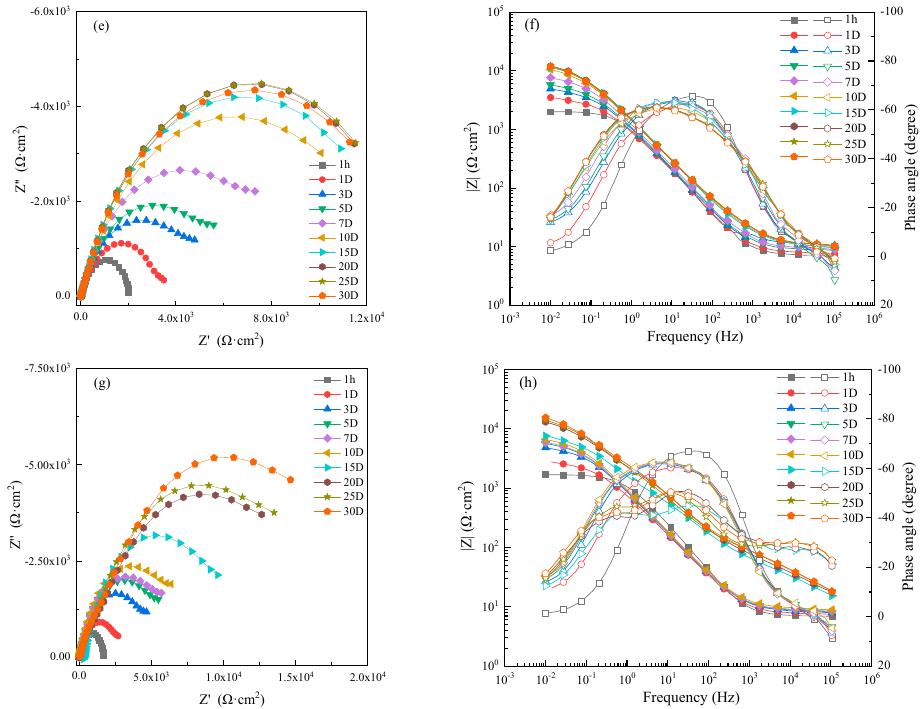
Figure 7. Electrochemical impedance spectra of HAZ in seawater: ( a , c , e , g ) Nyquist diagrams and ( b , d , f , h ) Bode diagrams in static, 1 m/s, 3 m/s, 5 m/s seawater. An EIS of 1 hour was fitted by the equivalent circuit shown in Figure 5a and those after 1 day were fitted with the equivalent circuit shown in Figure 5b. Then, the corrosion resistance R of HAZ was calculated according to the fitting results, which are shown in Figure 8. The corrosion resistance of HAZ in static seawater was also the biggest compared to that in flowing seawater. However, the corrosion resistance of HAZ in flowing seawater was smaller than that of MZ; that is to say, the corrosion resistance of HAZ was smaller than that of MZ.